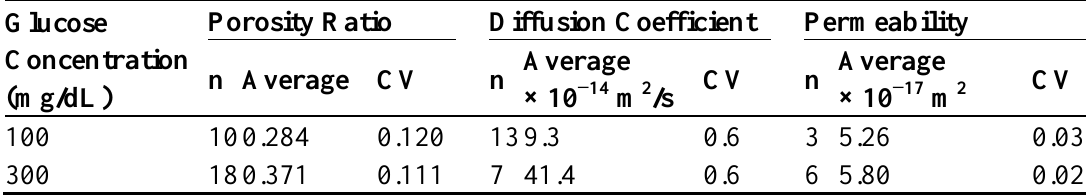
Table 2. Porosity ratio, diffusion coefficient, permeability of hydrogels exposed to 100 and 300 mg/dL glucose